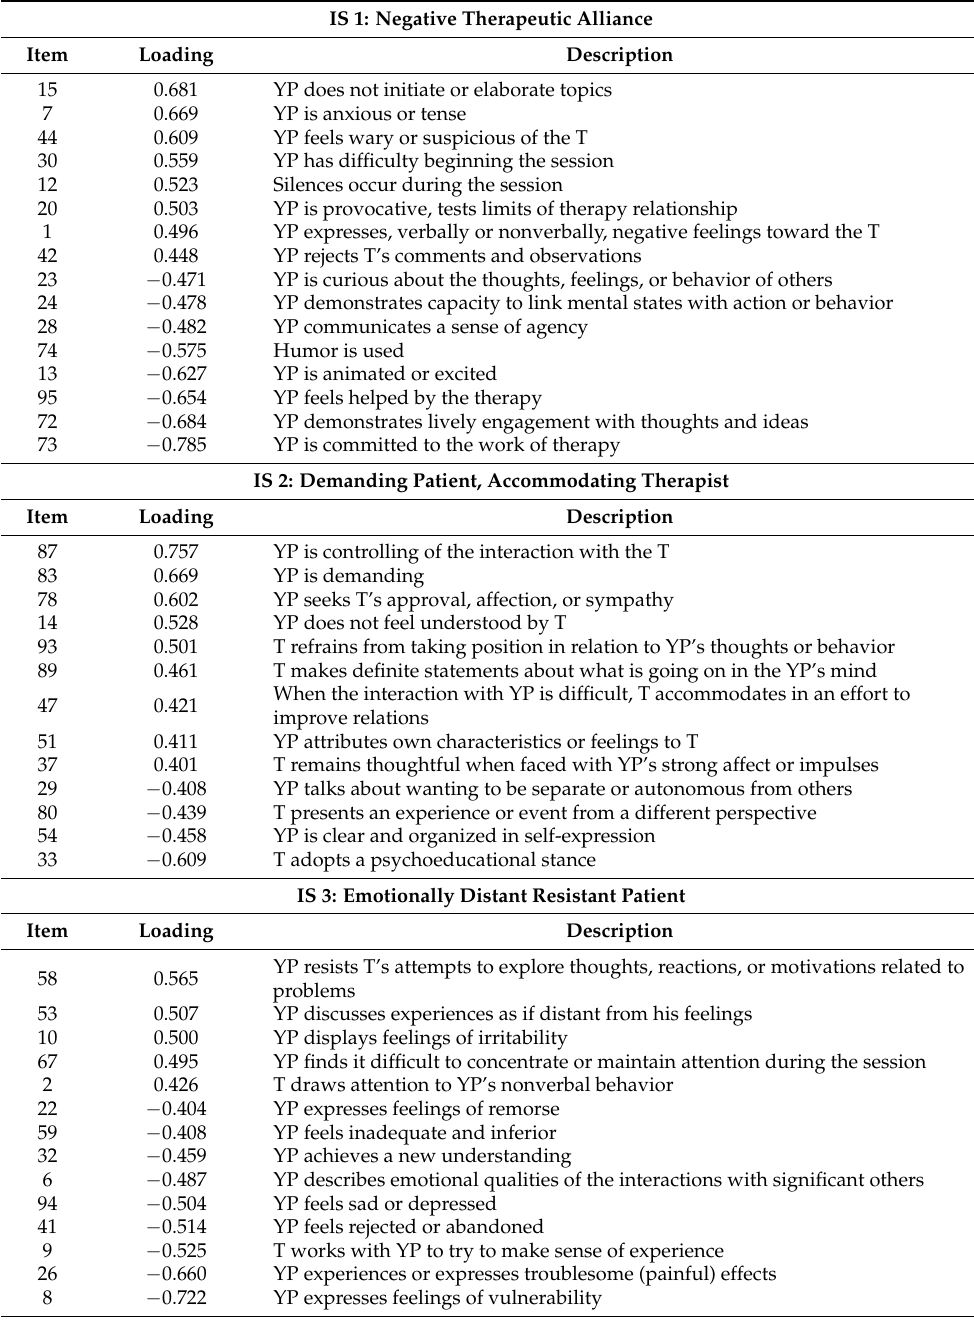
Table A1. Five-factor solution and item loadings of the APQ